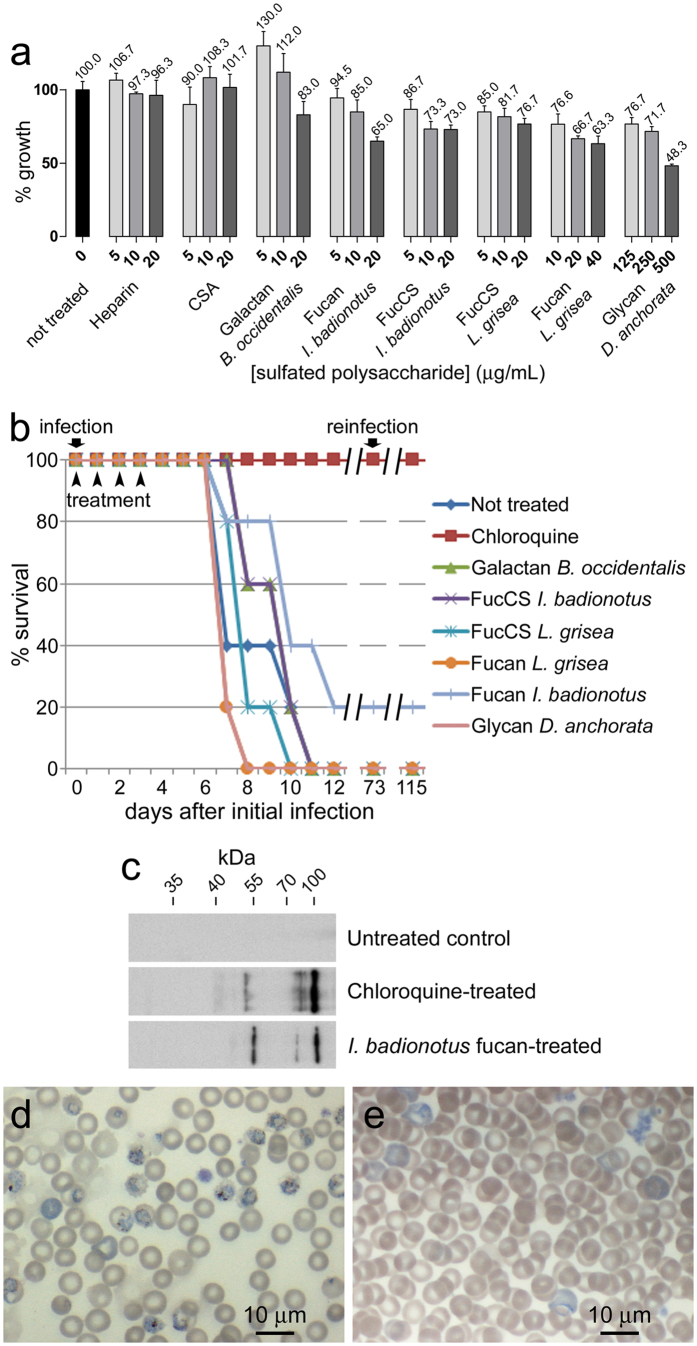
Cytotoxicity and in vivo antimalarial activity analyses of sulfated polysaccharides.(a) Unspecific toxicity for human umbilical vein endothelial cell cultures of sulfated polysaccharides assayed at concentrations around their respective IC50 for P. falciparum growth in vitro. The results are shown as the means of three independent experiments; the error bars represent standard deviations. (b) Kaplan-Meier plot for the in vivo assay of the effect on P. yoelii-infected mice (n = 5 animals/sample) of polysaccharides administered iv at the estimated μg mL−1 day−1 indicated in Table 3. Chloroquine was administered iv as a positive control at a dose of 5 mg kg−1 day−1. (c) Western blot for the detection of IgGs against P. yoelii antigens in the serum of surviving infected mice that had been treated 35 days before with chloroquine or with the I. badionotus fucan. The untreated control corresponds to a noninfected mouse of the same age. (d,e) Microscope images of blood samples from the surviving I. badionotus fucan-treated mouse at (d) day 4 and (e) day 40 after reinfection without further treatment.